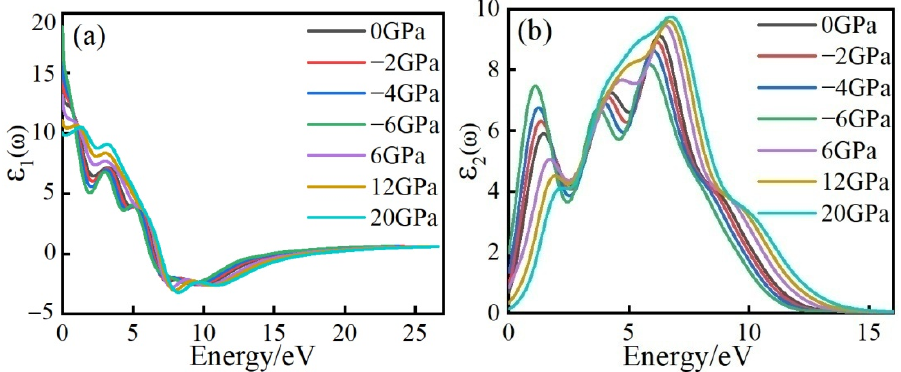
Figure 6. The complex dielectric function ofCu 2 ZnSnS 4 under stress for ( a ) the real part of the complex dielectric function; ( b ) the imaginary part of the complex dielectric function.